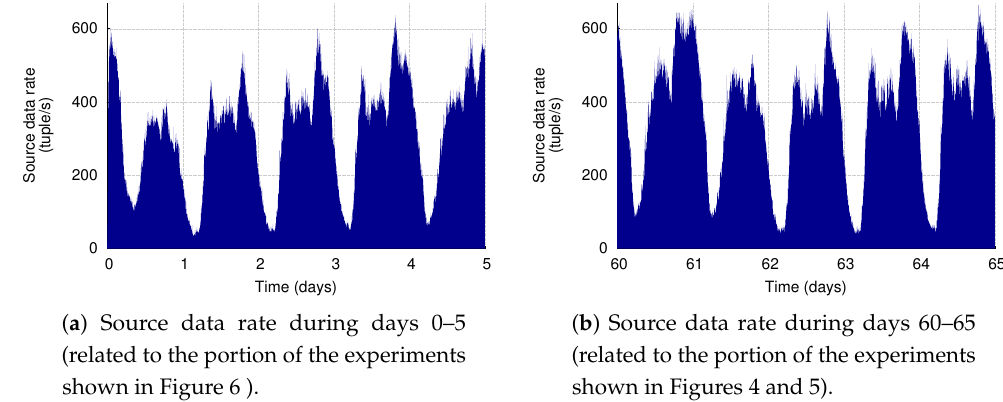
Figure 3. Workload used in our simulations, which is characterized by a daily